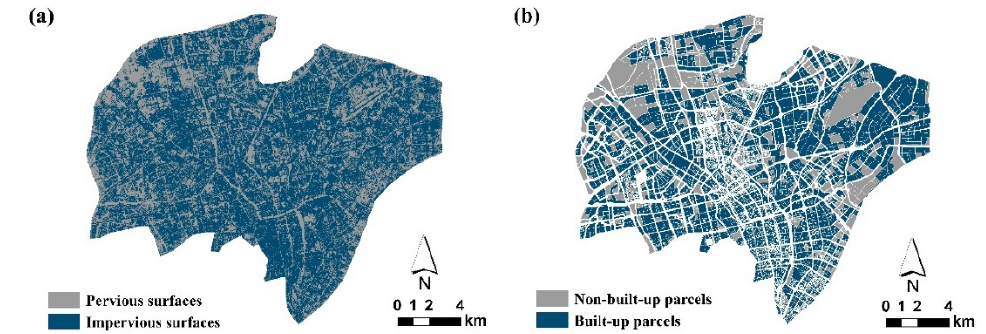
Figure 6. ( a ) Distribution of the pervious and impervious classes; ( b ) Distribution of the built-up and non-built-up